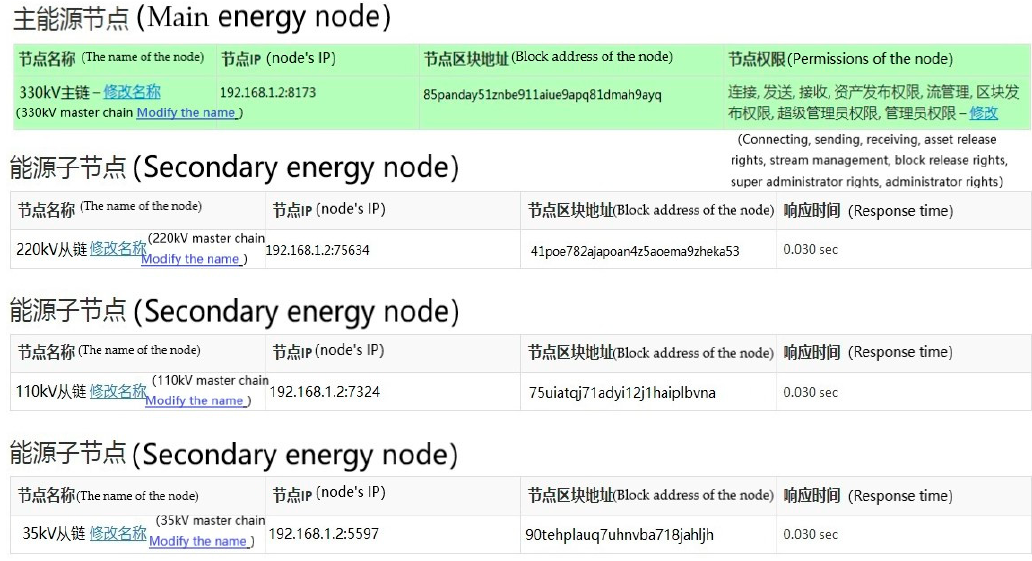
Figure A4. Master-slave node connection diagram.